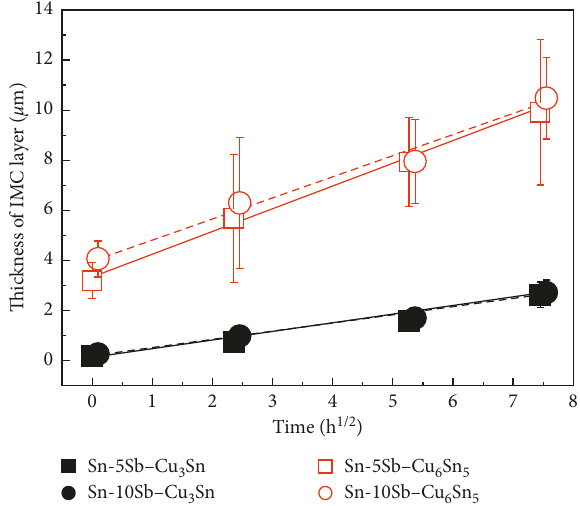
Figure 14: Relationship between the relative thickness of IMC layers in Sn-Sb/Cu joints and one-fifth of an actual processing time in the power cycling test, and relationship between those and aging time in the aging test at 200 °